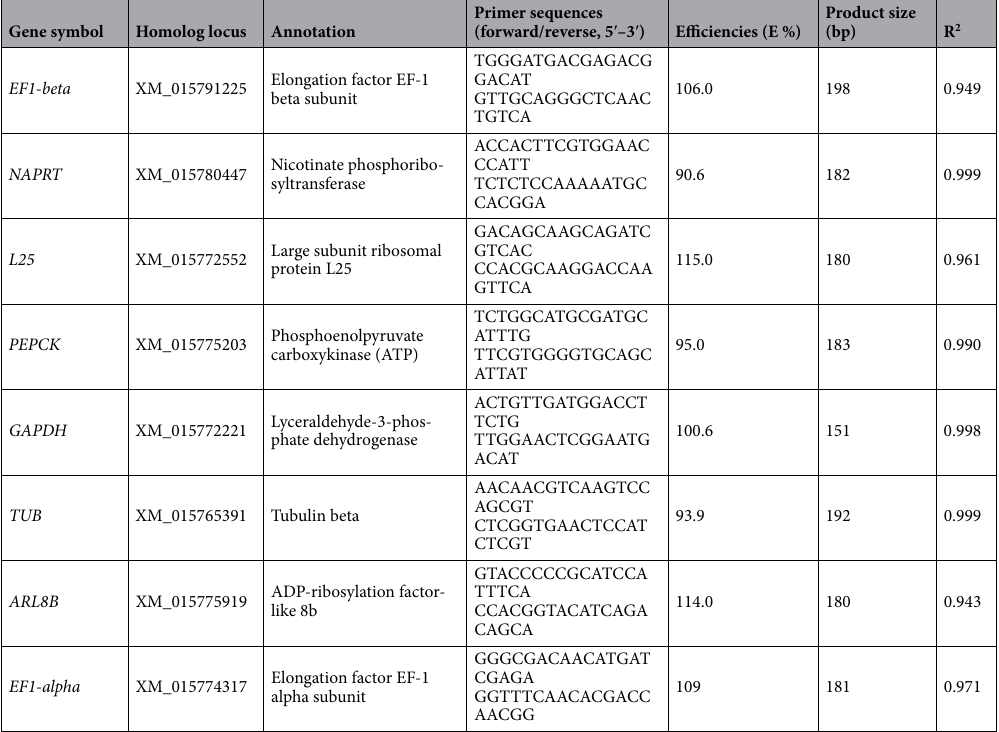
Table 1. Delineations of eight candidate reference genes in P. ternata and parameters gained by qRT-PCR